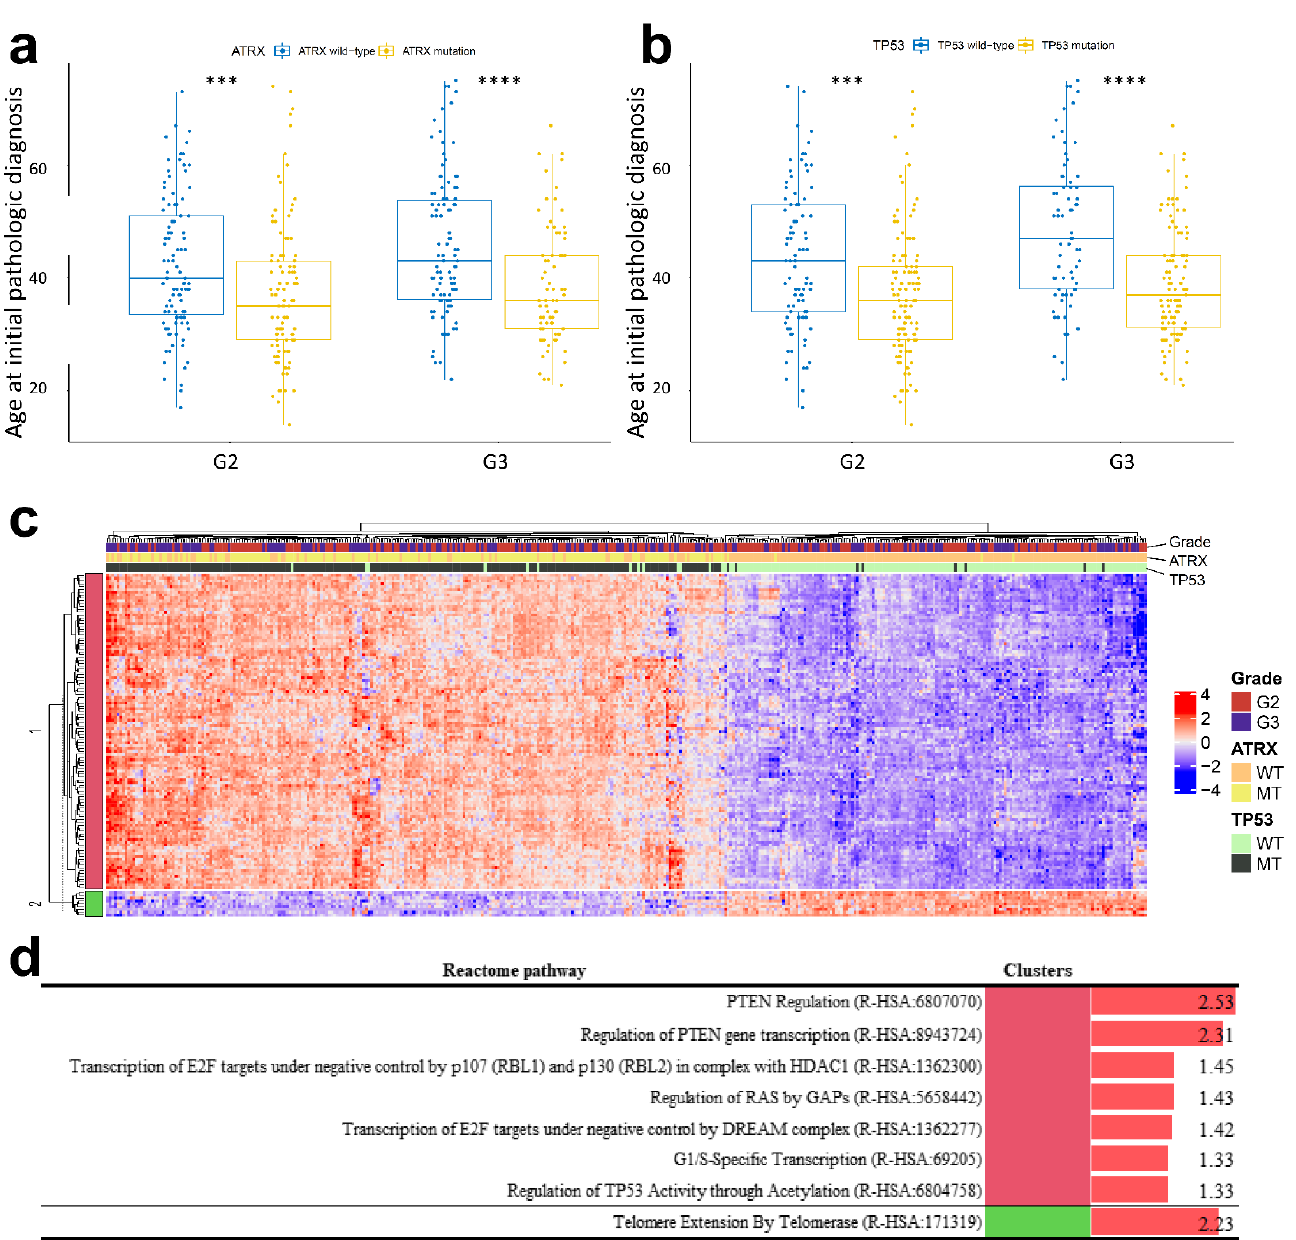
Figure 5. Comparison of patients harbouring ATRX and TP53 wild-type and mutation with age of glioma onset at initial pathological diagnosis in the background of IDH1 mutation. p -values less than 0.001 and 0.0001 are shown by *** and ****, respectively. As the number of glioblastoma (GBM) patients with IDH1 mutation is few, GBM is excepted in analysis ( a , b ). Heatmap with the hierarchical tree of patients by gene expression pattern with information gain (IG) over 0.35. The top annotations show the grade and mutational status (mutant or wild-type) of ATRX and TP53 . WT indicates wild-type; MT indicates mutation ( c ). Statistically significant results of pathway enrichment analysis of gene clusters in the ATRX and TP53 hierarchical group ( d